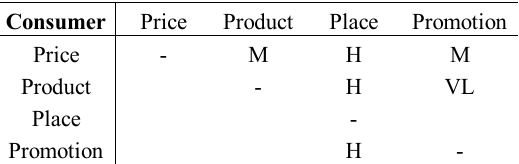
Table4. Pairwise comparisons of alternatives with respect to Consumer.